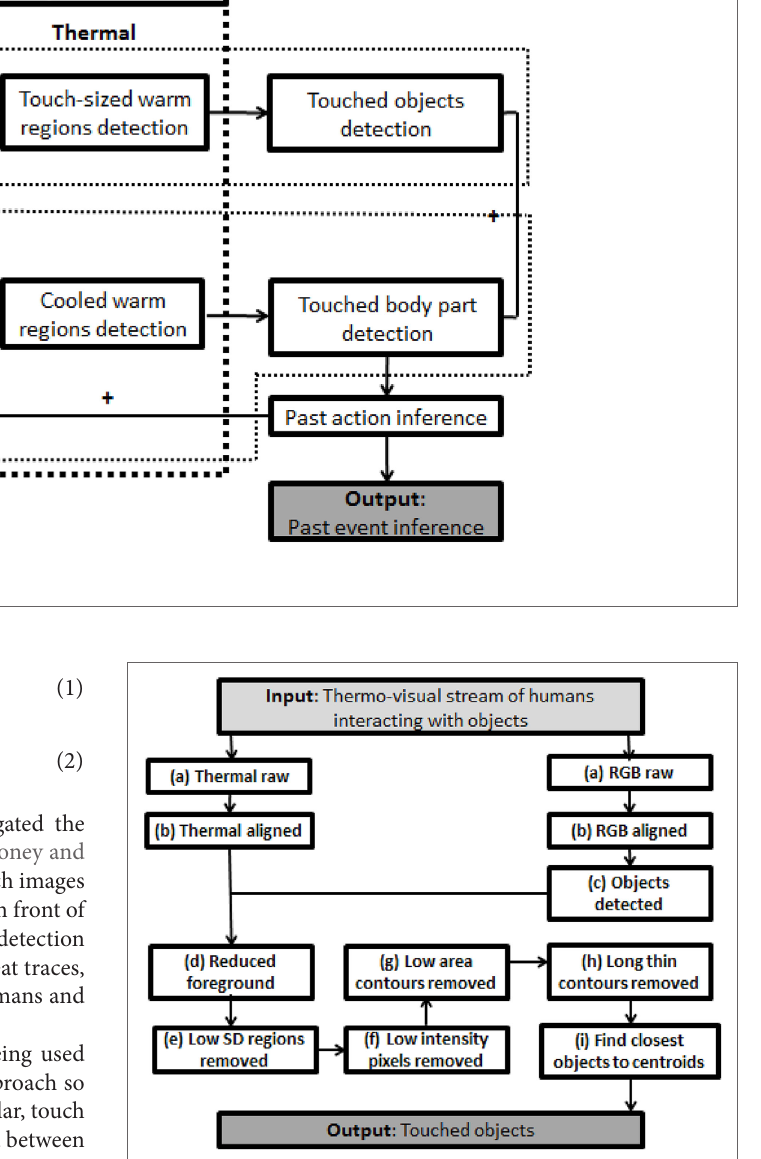
FigUre 3 | Object touch detection process flow for the rule-based version of our approach. Note: the automated version of our approach combines steps